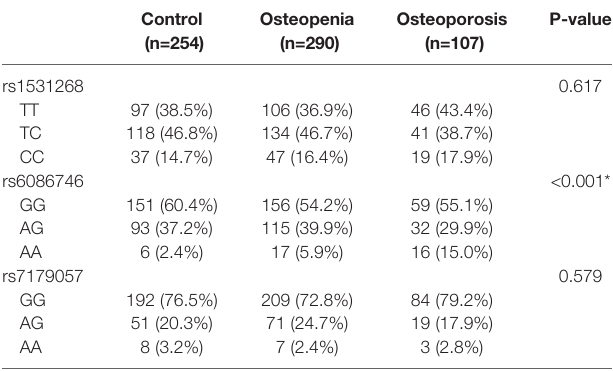
TABLE 2 | Genotypic characteristics of participants in this study.